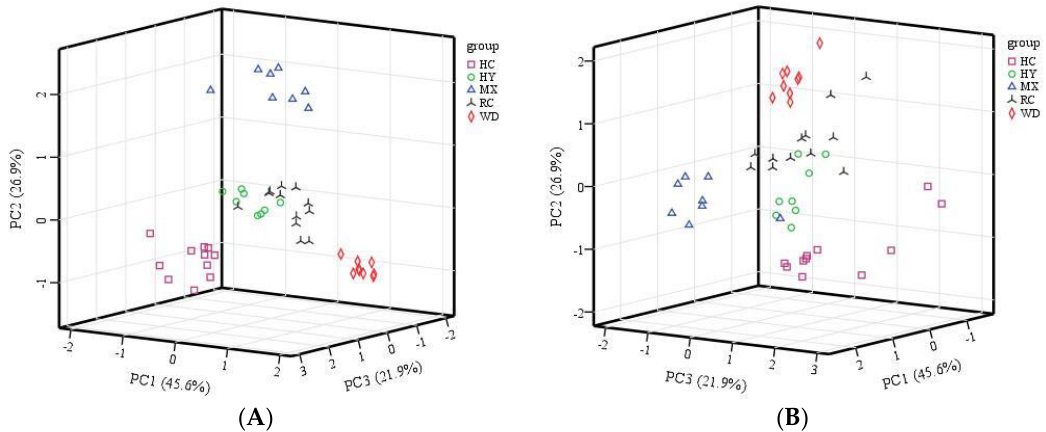
Figure 2. Three-dimensional principal component score plot using the first three score vectors ( A ) front view and ( B ) rear view.